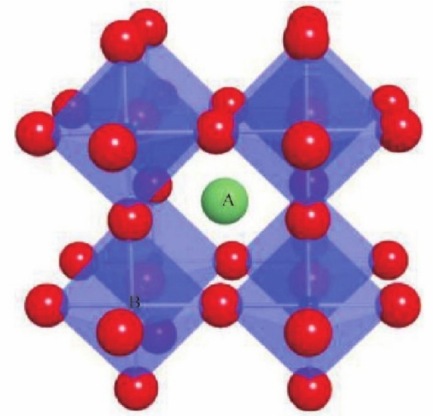
Figure 7. Perovskite crystal structure. Reproduced with the permission of ref. [47]. Copyright 2021, Chemical Industry and Engineering